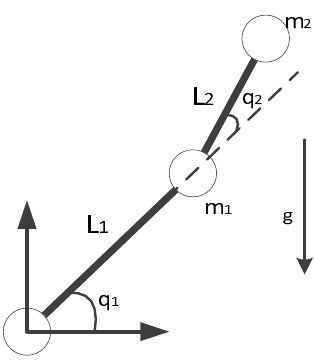
Figure 5. Simplified schematic diagram of two-joint manipulator.